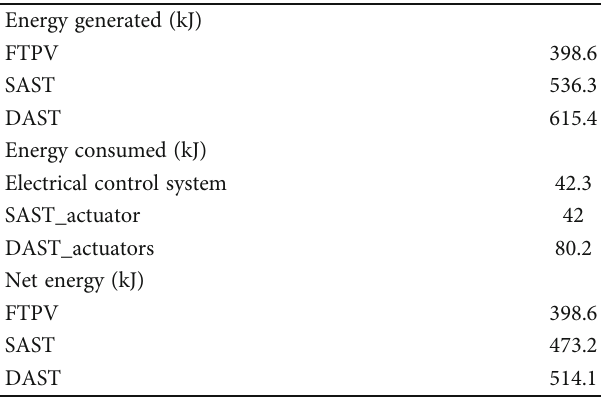
Table 2: Energy generated, consumed, and net energy via each